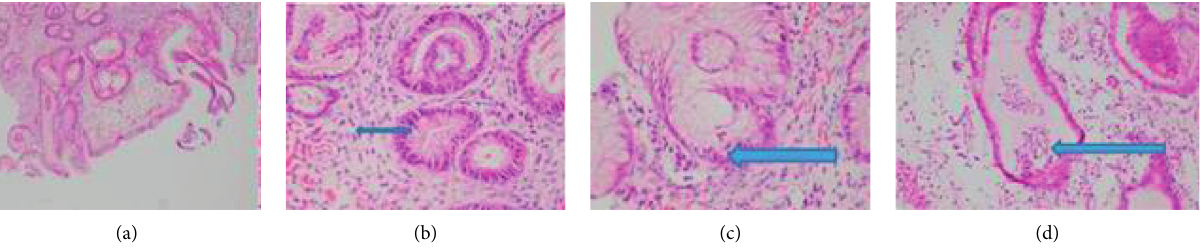
Figure 3: Histologic findings of gastric biopsy; the gastric mucosa shows (a) severe inflammation, ulcerations, and architecture changes, (b) plasmacytosis in the lamina propria, (c) inflammation in the gastric foveolar epithelium, and (d) microabscess formations.